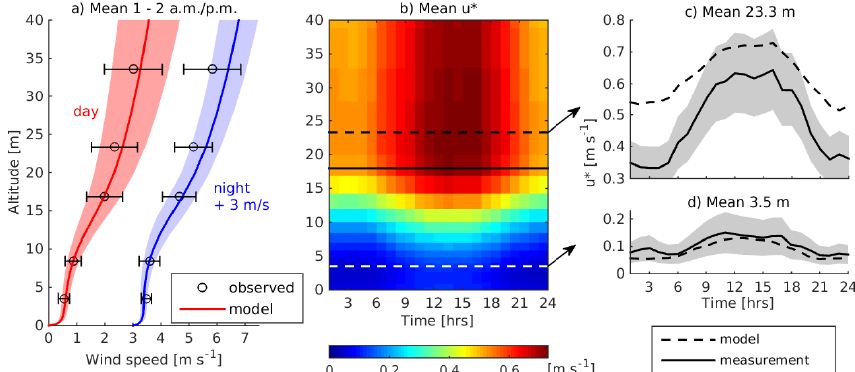
Figure 5. Average wind speed profile ± SD at 1–2a.m. and p.m. (a) . Red and blue lines and area are simulated values for day and night SD at 1–2 a.m. and p.m. (a) . Red and blue lines and area are Figure 4. Average wind speed profile (3ms − 1 added for clarity), respectively, black from measurements. Simulated diurnal mean friction velocity ( u ∗ ) (b) . The top of the canopy ± simulated values for day and night (3 m/s added for clarity), respectively, black from measurements. is shown with a solid line and the measurement heights of the eddy covariance systems with dashed lines. Observed and simulated mean Simulated diurnal mean friction velocity ( u ∗ ) (b) . The top of the canopy is shown with a solid line and friction velocity in (d) and above the canopy (c) . The shaded areas in (c) and (d) represent the estimated uncertainty of ± 20% (c) and ± 50% (d) , respectively. the measurement heights of the eddy covariance systems with dash lines. Observed and simulated mean friction velocity in (d) and above the canopy (c) . The shaded areas in the ( c and d ) represents 20 % (c) and 50 % (d) , respectively. the estimated uncertainty of ± ±